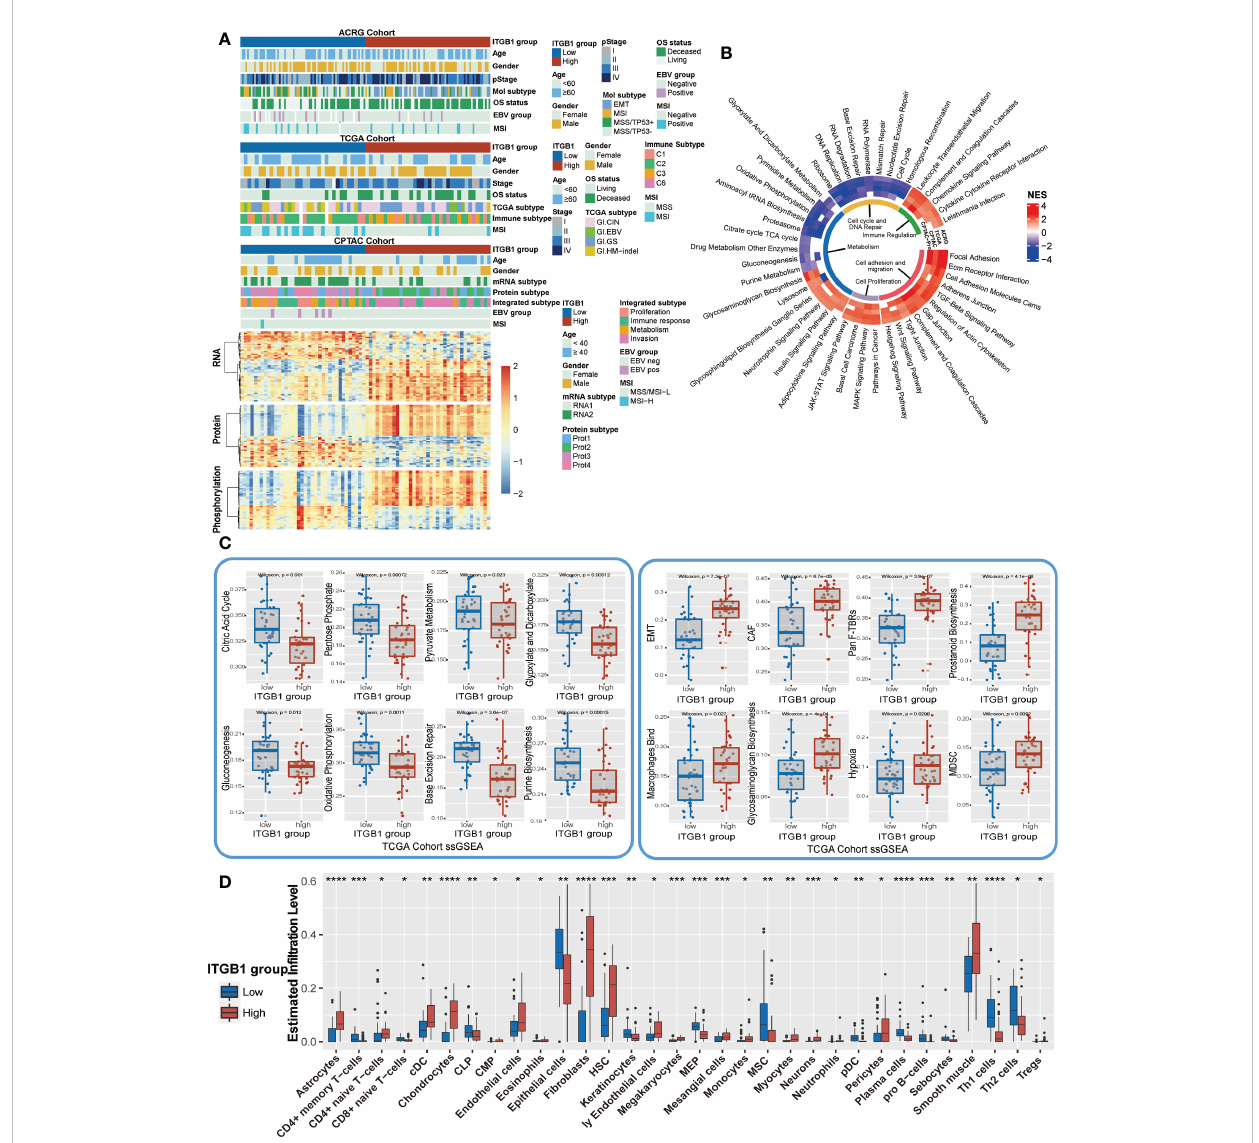
FIGURE 5 Enrichment analysis of ITGB1 related genes, pathways and immune regulation alteration (A) The relative RNA and protein expression of cell proliferation, cell cycle, metabolism, cell adhesion and immune regulation in different ITGB1 groups were evaluated in ACRG TCGA and CPTAC cohorts. (B) Enriched analysis in different pathways (Immune regulation, Cell cycle and DNA repair, Metabolism, Cell proliferation and Cell adhesion and migration). (C) Related metabolism and other pathways ssGSEA was calculated and compared in different ITGB1 groups from TCGA cohort. (D) The relative abundance of tumor-in fi ltrating leukocytes (TILs) with ITGB1 grouping in diffuse GC from TCGA datasets was estimated by the CIBERSORT algorithm. *, P<0.05; **, P<0.01; ***, P<0.001; ****,